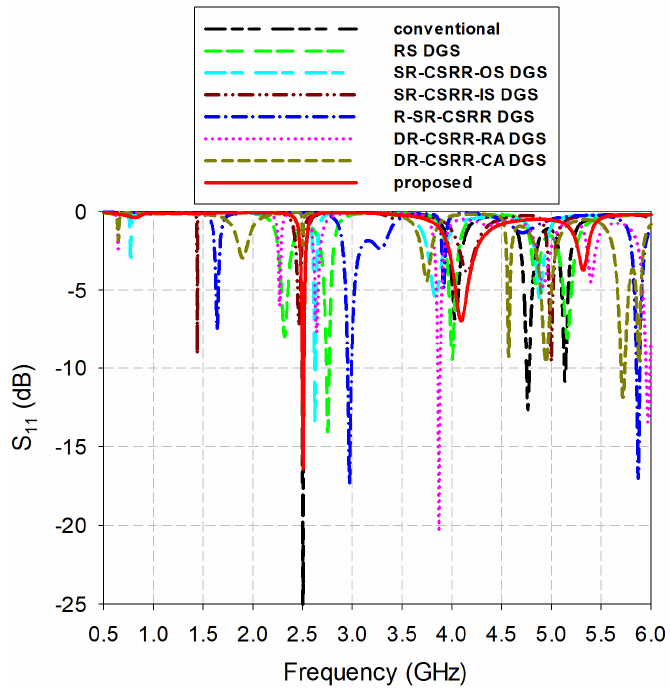
Figure 2. Input reflection coe ffi cient characteristics vs. frequency for the eight MPSAs in Figure